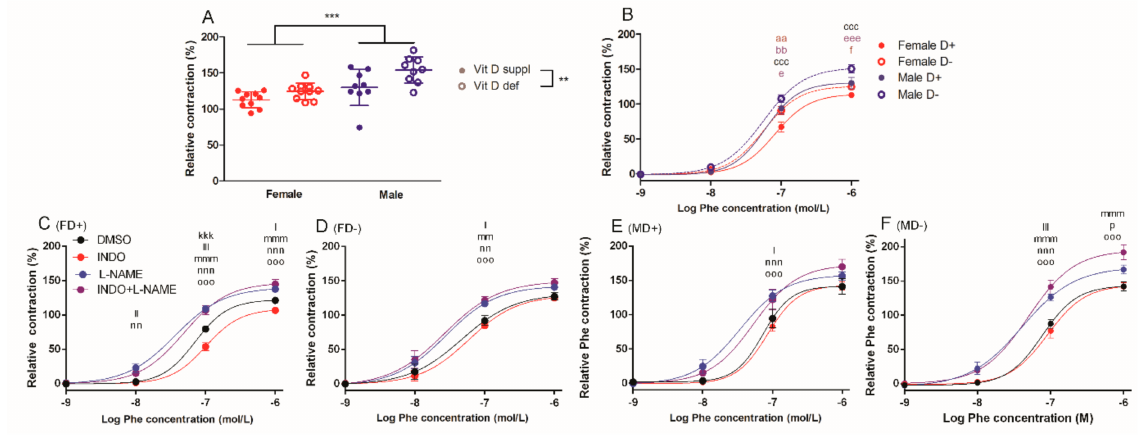
Figure 1. Contraction ability of isolated carotid artery segments: ( A ) phenylephrine (Phe)-induced contraction in the four experimental groups at 10 − 6 mol/L Phe concentration. Male gender and vitamin D deficiency were associated with more pronounced relative contraction. Data are shown as individual data points; horizontal lines represent mean ± SD. Two-way ANOVA; factors: gender, vitamin D status. **: p < 0.01, ***: p < 0.001. ( B ) Phe-induced contraction. Male rats showed significantly increased contraction compared to females at Phe concentration of 10 − 7 mol/L independently from vitamin D status. Vitamin D deficient female vessels had stronger contraction compared to their vitamin D supplemented counterparts. At Phe concentration of 10 − 6 mol/L, MD − arteries contracted more than FD − ones. Vitamin D deficient male rats showed increased contraction compared to their vitamin D supplemented counterparts. Data are shown as mean ± SEM; n = 9–11 in each group; repeated measures ANOVA, Bonferroni’s post hoc test; aa: p < 0.01 FD+ vs. FD − , bb: p < 0.01 FD+ vs. MD+, ccc: p < 0.001 FD+ vs. MD − , e: p < 0.05 FD − vs. MD − , eee: p < 0.001 FD − vs. MD − , f: p < 0.05 MD+ vs. MD − . Phe-induced contractions in the presence of L-NAME and/or indomethacin (INDO) or their vehicle DMSO ( C ) in female vitamin D supplemented rats (FD+) ( D ) in female vitamin D deficient rats (FD − ), ( E ) in male vitamin D supplemented rats (MD+) and ( F ) in male vitamin D deficient rats (MD − ). L-NAME increased the level of contraction in all experimental groups. Co-incubation with INDO further augmented the contraction only in MD − rats. INDO itself decreased the degree of vascular reaction only in the FD+ group. Data are shown as mean ± SEM; n = 5–11 in each group; repeated measures ANOVA, Bonferroni’s post hoc test; kkk: p < 0.001 DMSO vs. INDO, l: p < 0.05 DMSO vs. L-NAME, ll: p < 0.01 DMSO vs. L-NAME, lll: p < 0.001 DMSO vs. L-NAME, mm: p < 0.01 DMSO vs. INDO+L-NAME, mmm: p < 0.001 DMSO vs. INDO+L-NAME, nn: p < 0.01 INDO vs. L-NAME, nnn: p < 0.001 INDO vs. L-NAME, ooo: p < 0.001 INDO vs. INDO+L-NAME, p: p < 0.05 L-NAME vs.